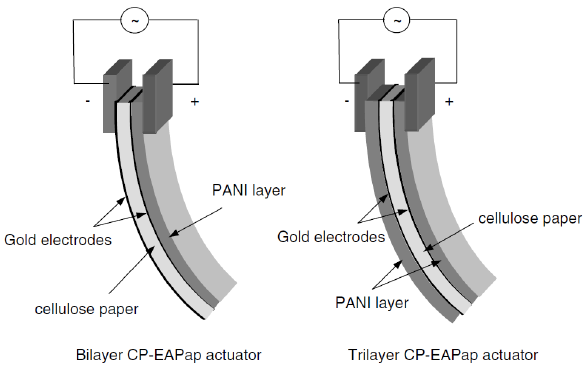
Figure 2. Bi- and trilayer polyaniline coated electroactive paper actuators [32] .